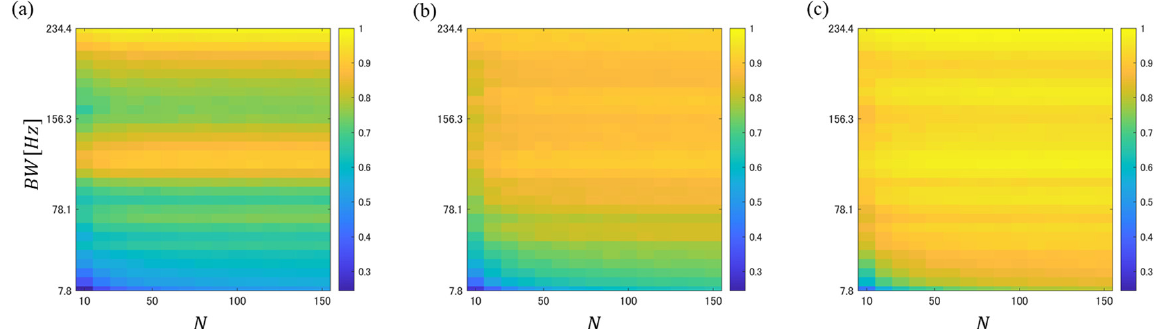
Figure 3. PFHS plots between ( a ) BSI-BWI, ( b ) BSI-ASI, and ( c ) BWI-AWI when the number of BS episodes and BW were varied during the creation of the PFH.